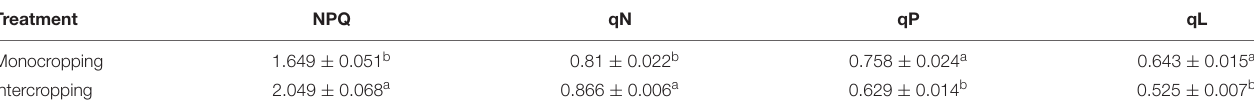
FIGURE 4 | Diurnal variation of P n , C i , Y(II), and NPQ of soybean leaf in monocropping and intercropping. (A) Pn, net photosynthetic rate, (B) Ci, intercellular CO 2 concentration, (C) Y(II), the photochemical efficiency of PSII, and (D) NPQ, non-photochemical quenching parameter. TABLE 3 | Effect of high light on the mode of the yields for dissipative processes for the energy absorbed by PSII of soybean at midday (12:30